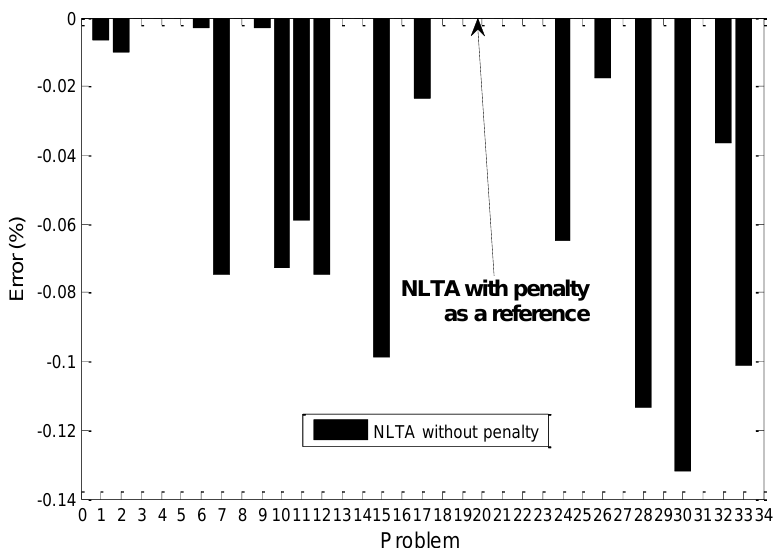
Figure 3. Effect of the penalty on NLTA in case of binary-state